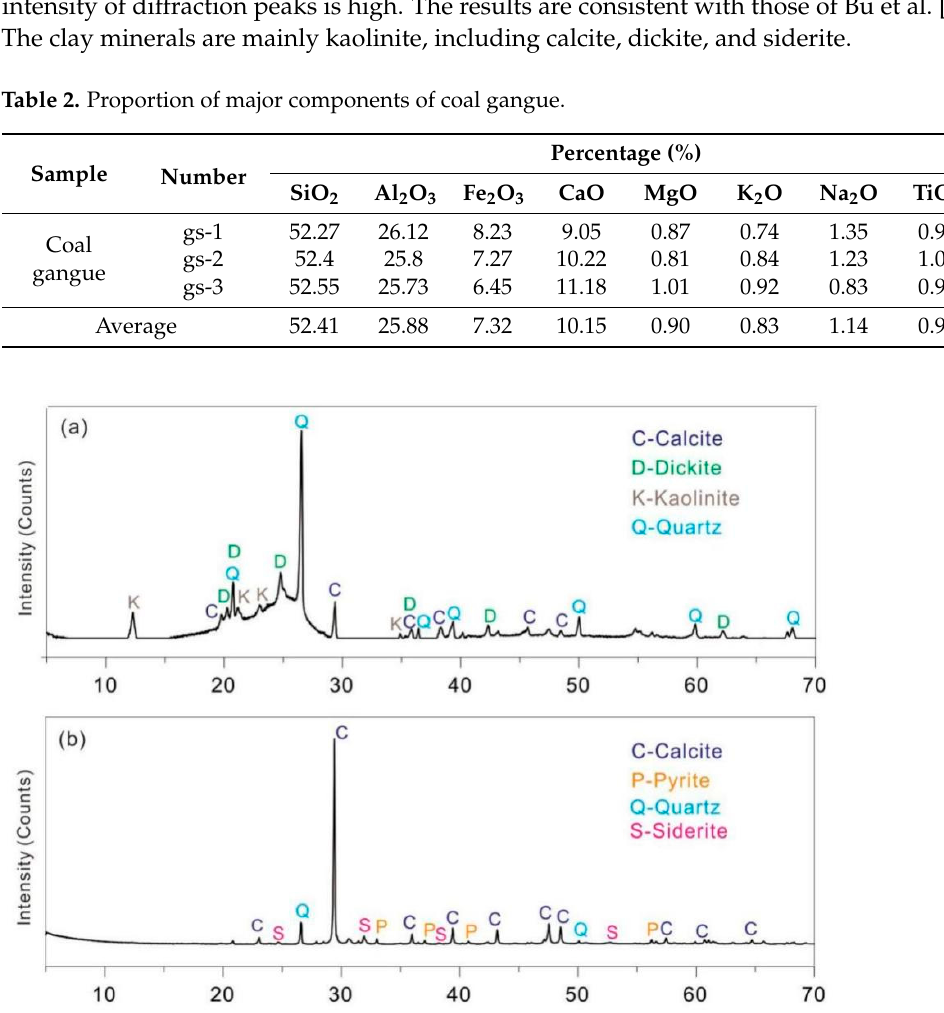
Figure 3. The XRD test results of coal gangue samples: ( a ) gs-1 sample; ( b ) gs-2 sample. The proportion is calculated by mass fraction.